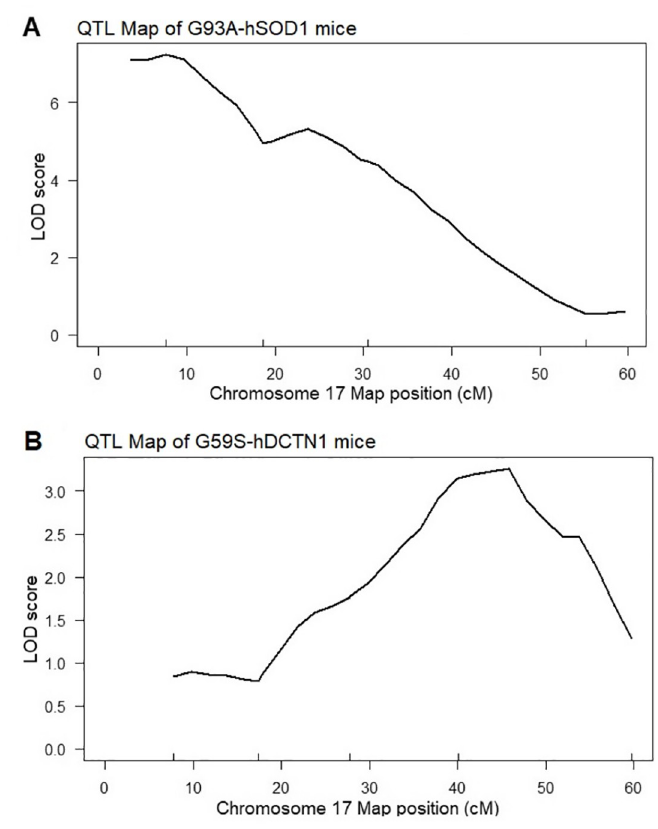
Fig 5. LOD plots of chromosome 17 QTLs of SOD1 and dynactin-1 transgenic mice. Chromosome 17 LOD plots. [A] Chromosome 17 Survival QTL in F2 B6xSJL G93A-hSOD1 mice. [B] Chromosome 17 Survival QTL in F2 B6xSJL G59S-hDCTN1